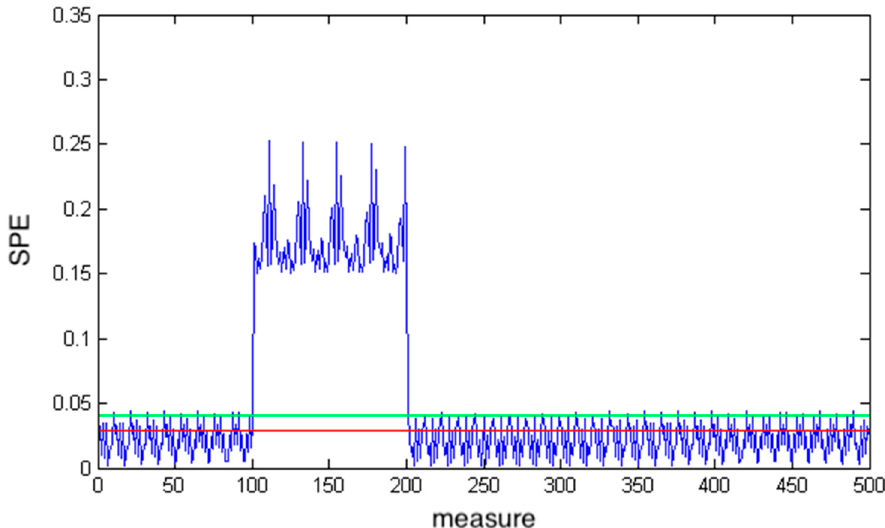
Figure 4. Fault simulation of detail coefficient at scale 3 of X 2 .